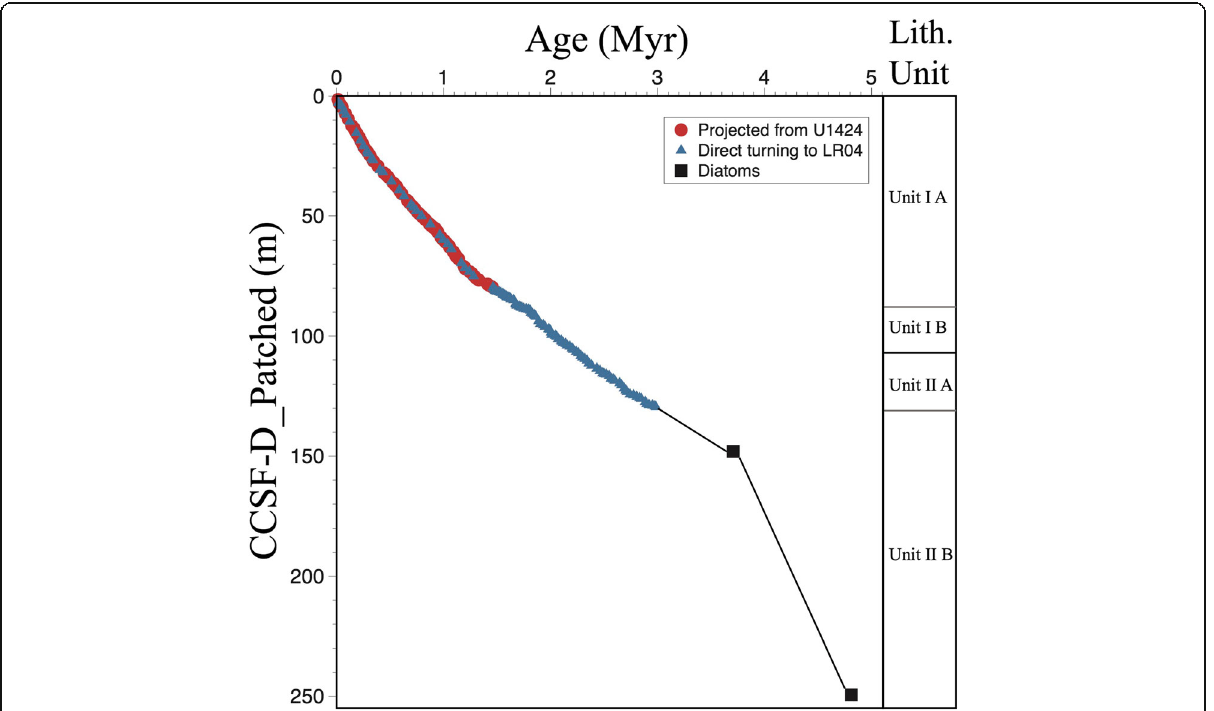
Fig. 3 The age-depth relationship of the revised age model for site U1423 used in this study. The age control points from the Expedition Report (Tada et al. 2015) is also indicated by the black dots and